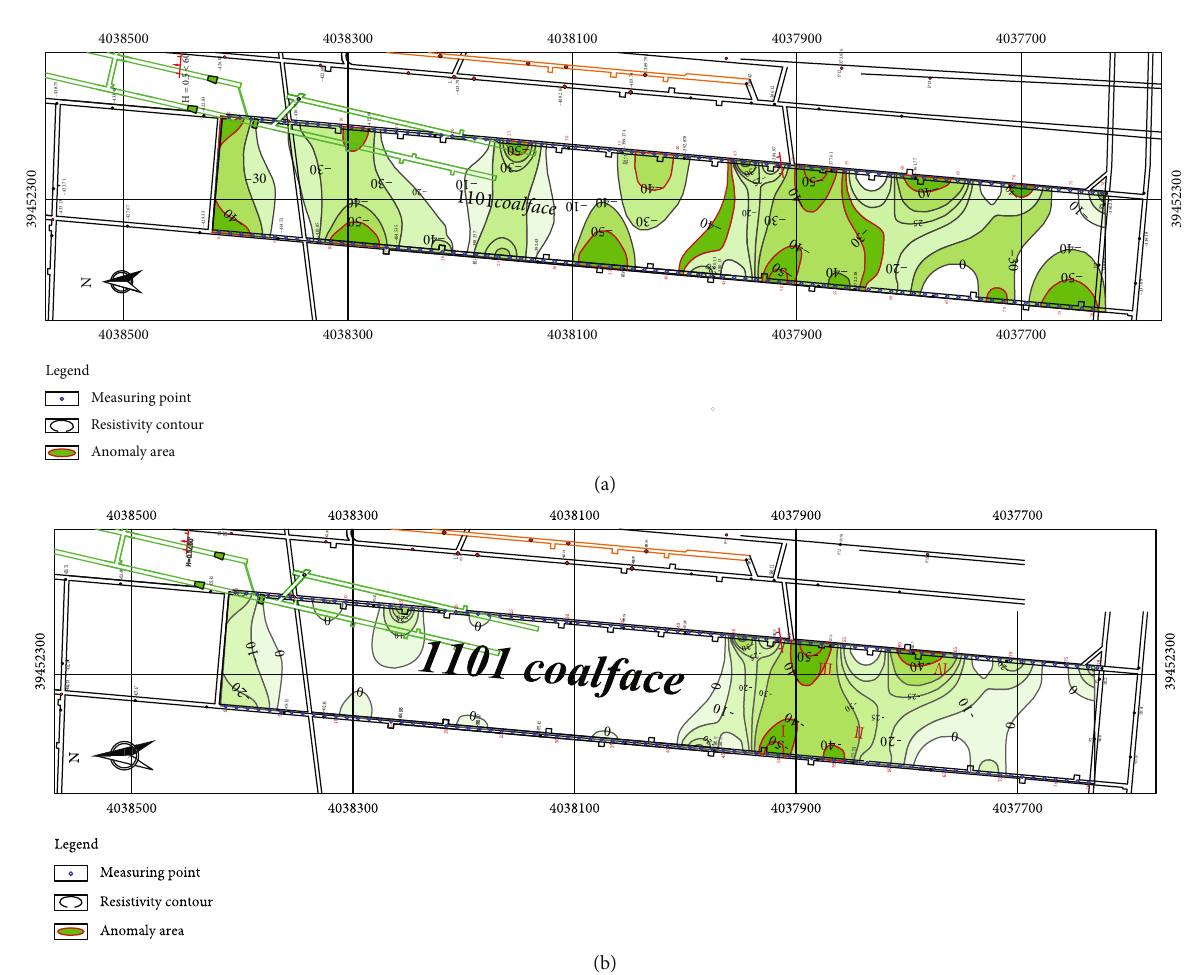
Figure 6: Isoline section of low resistivity abnormal area of Xujiazhuang limestone aquifer before and after the grouting